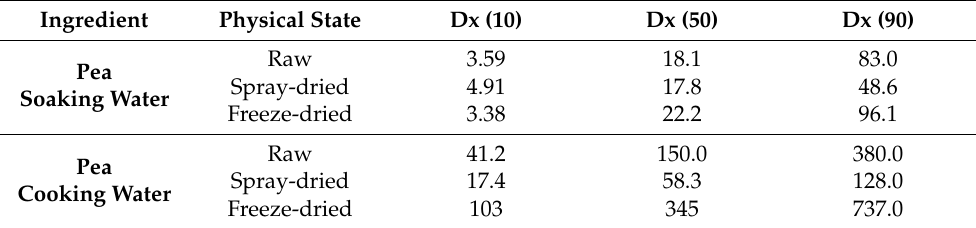
Table 3. The particle sizes of raw/spray-dried/freeze-dried split yellow pea soaking/cooking water.